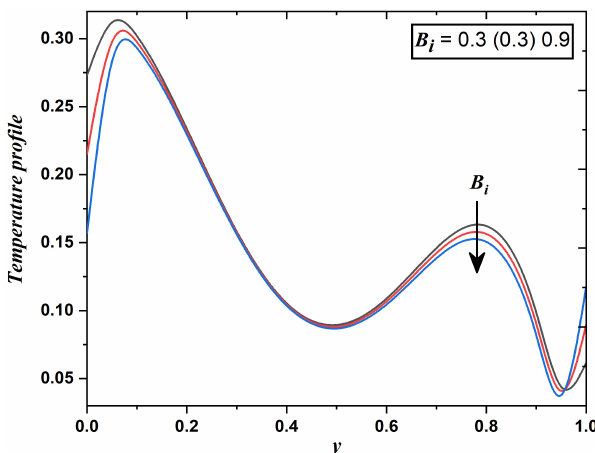
Figure 8. Temperature field when Prandtl number varies (Case 1 & 2).